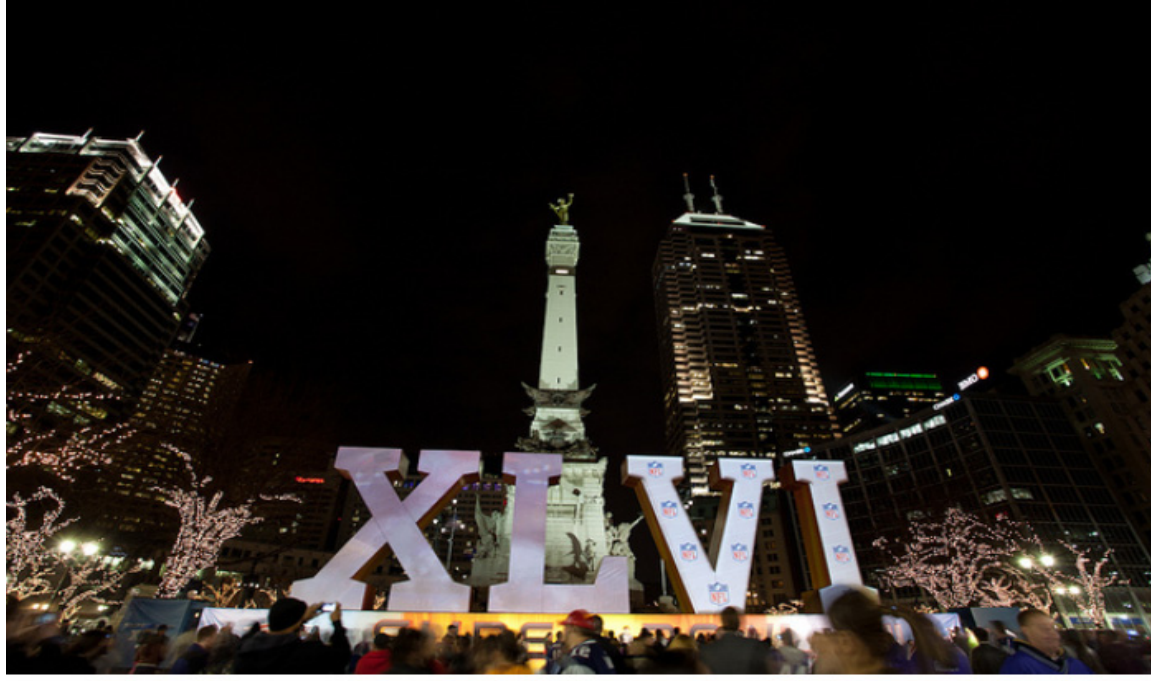
Figure 1. Super Bowl XLVI, Monument Circle, Indianapolis display [43]. Photo Credit: Curtis Billue.